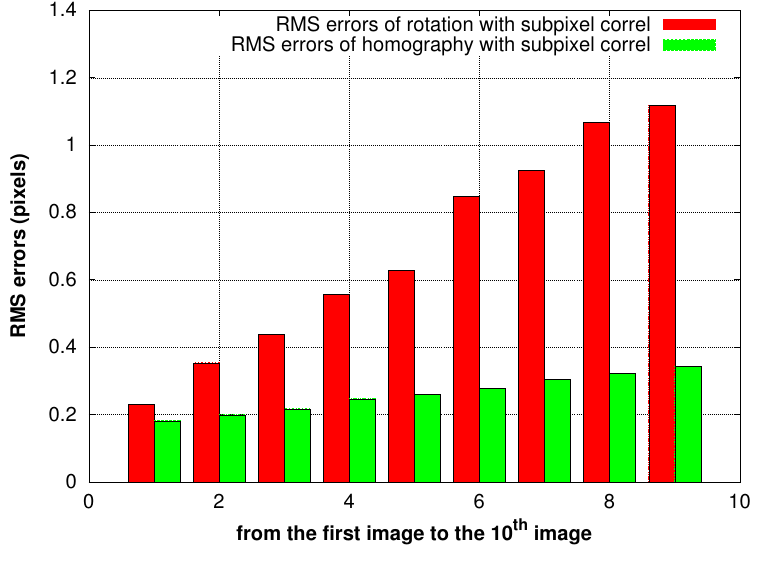
Figure 18. Residuals of the estimation of 3D rotation and 2D homography between the first image and all other images in the case of UAV